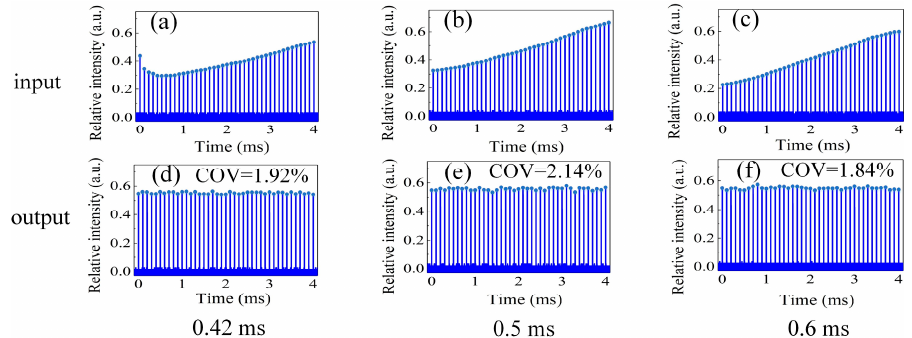
Figure 5. Input and output envelope of pre-shaped flat-top burst profile at amplification delays of 0.42 ms, 0.5 ms, and 0.6 ms. ( a – c ): Input profile of pre-shaped envelope; ( d – f ): Output profile of pre-shaped envelope.